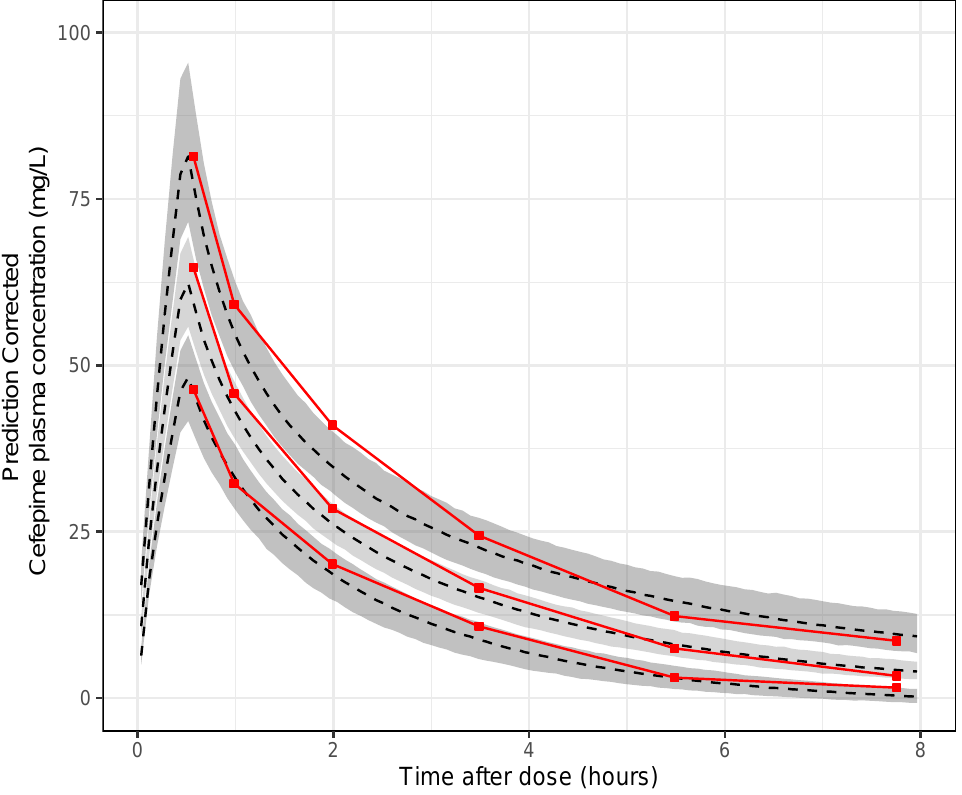
Figure 1. Prediction corrected Visual Predictive Check (pcVPC); red solid line, 10th, 50th, 90th percentiles of the observations; red solid dots, central location of bins used to calculate percentiles; gray dashed line, 10th, 50th, 90th prediction intervals of simulations; shaded area 95% confidence interval from prediction intervals obtained from